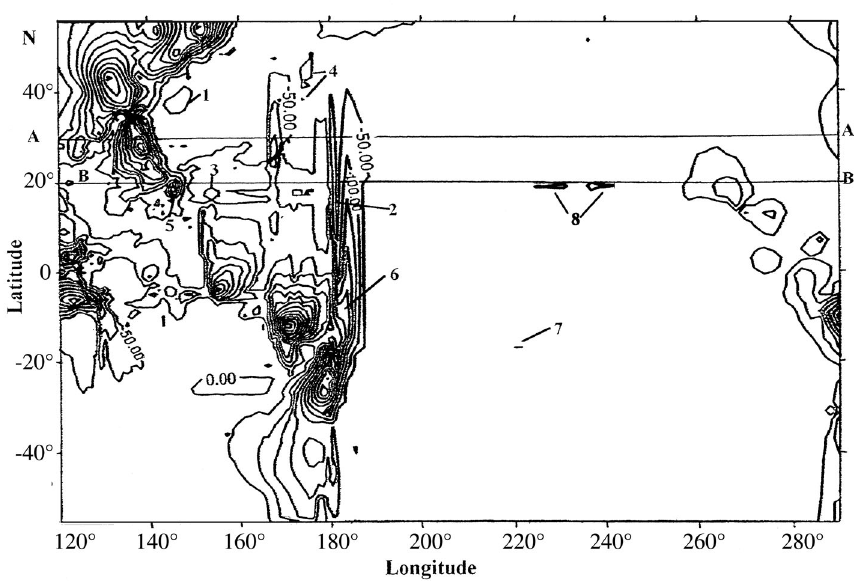
Fig. 6. The map of depth of earthquake hypocenters (in km) for the Pacific Ocean region. Uplifts: numbers 1- 8 denote same as fig.